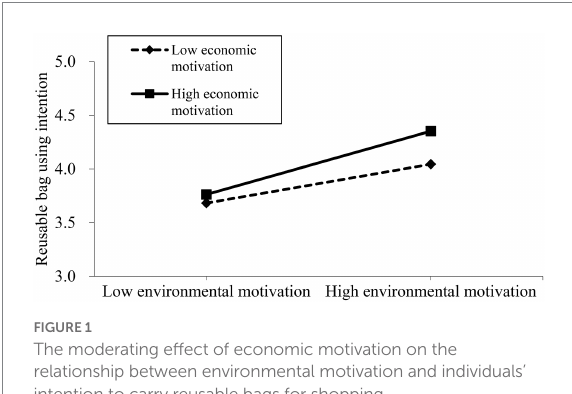
FIGURE 1 The moderating effect of economic motivation on the relationship between environmental motivation and individuals’ intention to carry reusable bags for